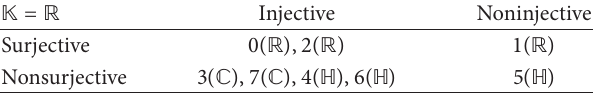
This gives the following